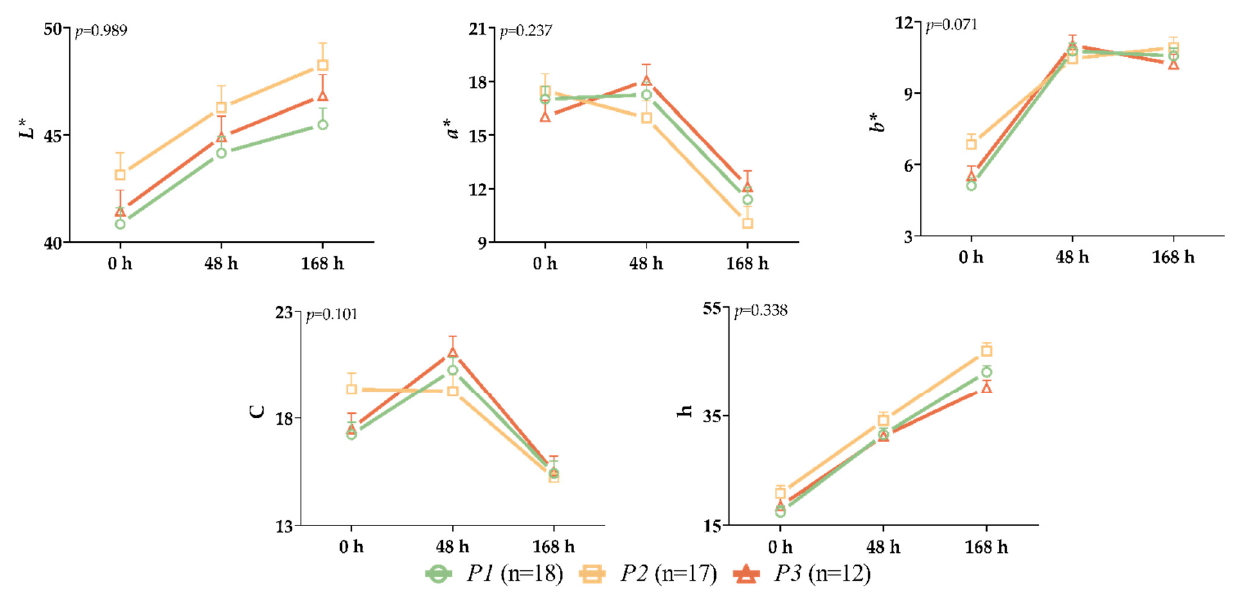
Figure 8. Genotype × time interaction on color parameters of Longissimus thoracis et lumborum muscle during the storage period. L *: lightness, a *: redness, b *: yellowness, C: chroma, h: hue.